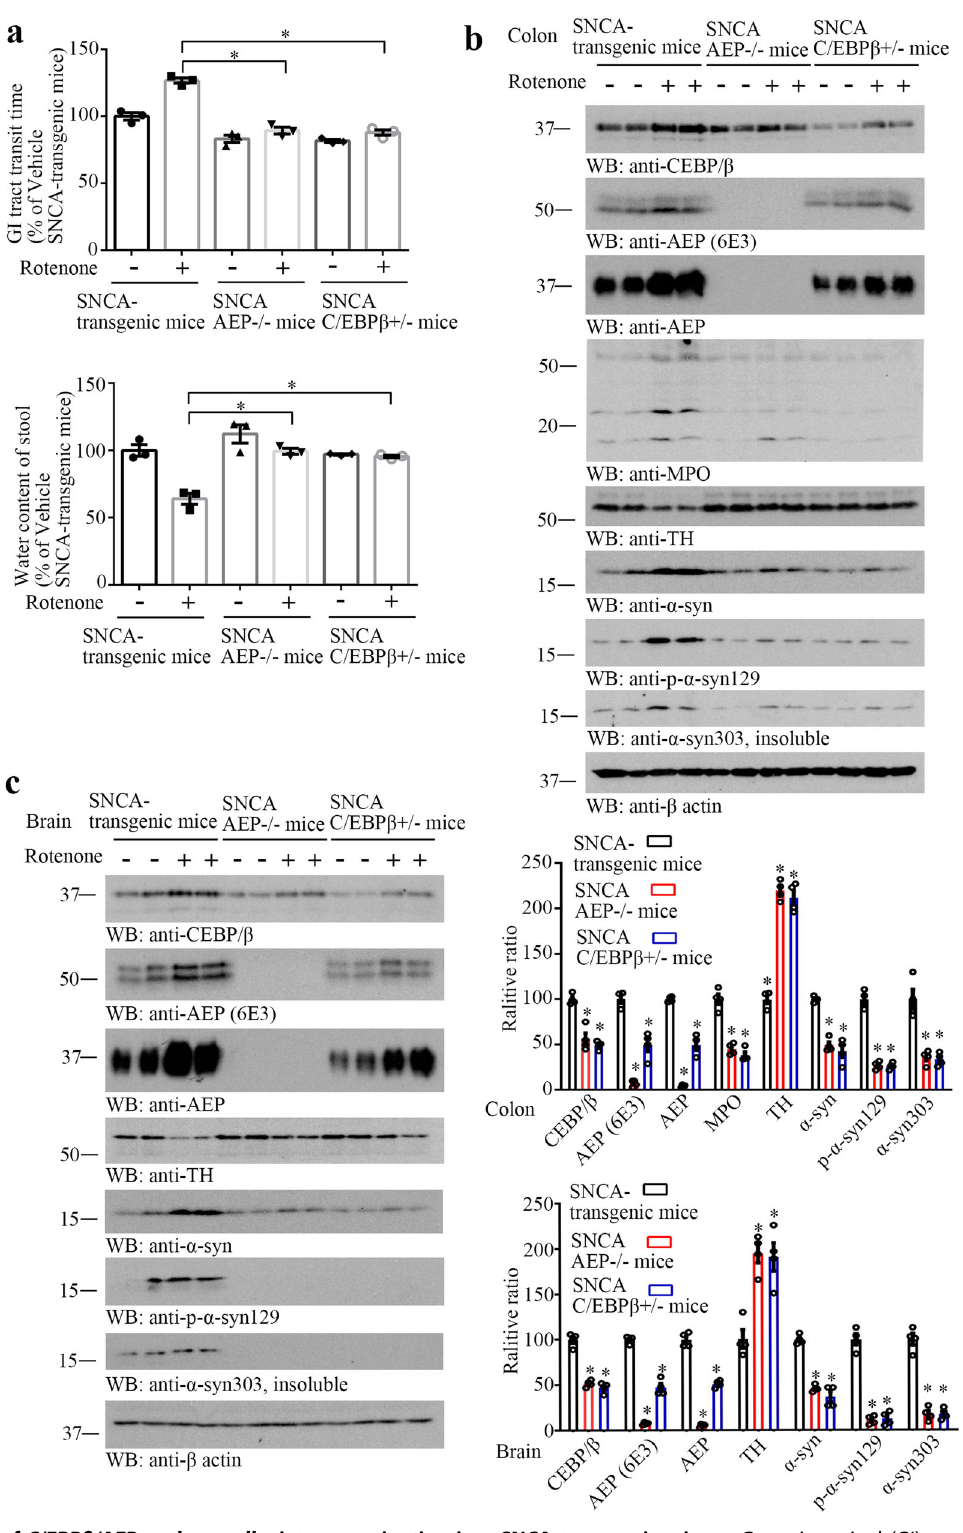
Fig. 5 Knockout of C/EBP β /AEP pathway alleviates constipation in α -SNCA transgenic mice. a Gastrointestinal (GI) tract transit time and water content of stool in the mice. ( n = 3 per group, * P < 0.05 vs rotenone treated α -SNCA transgenic mouse, one-way ANOVA). Western blot showing C/EBP β , AEP, MPO, TH, α -Syn, and p- α -Syn 129 expressing in the mouse colon ( b ) and C/EBP β , AEP, TH, α -Syn, and p- α -Syn 129 expressed in the mouse brain ( c ). Quanti fi cation of western blotting ( n = 4 per group, * P < 0.05 vs rotenone treated α -SNCA transgenic mouse, one-way